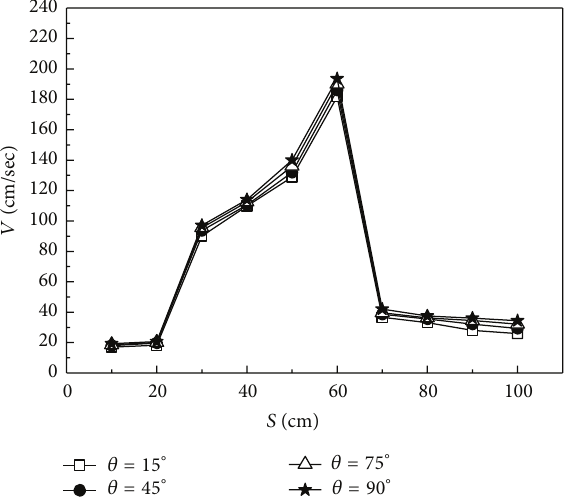
Figure 7: Position of bubble front corresponds to the velocity of bubble for 0.5 wt% CMC with gas flow 600